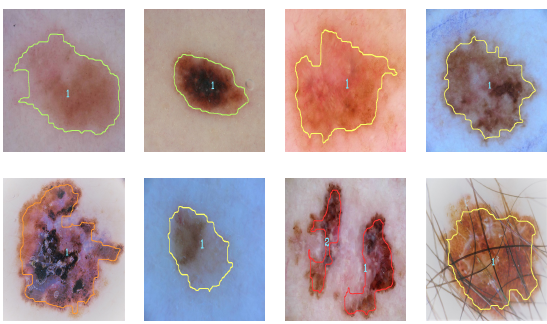
Figure 10. Examples of identification and classification of malignant melanoma cases in dermatological images.